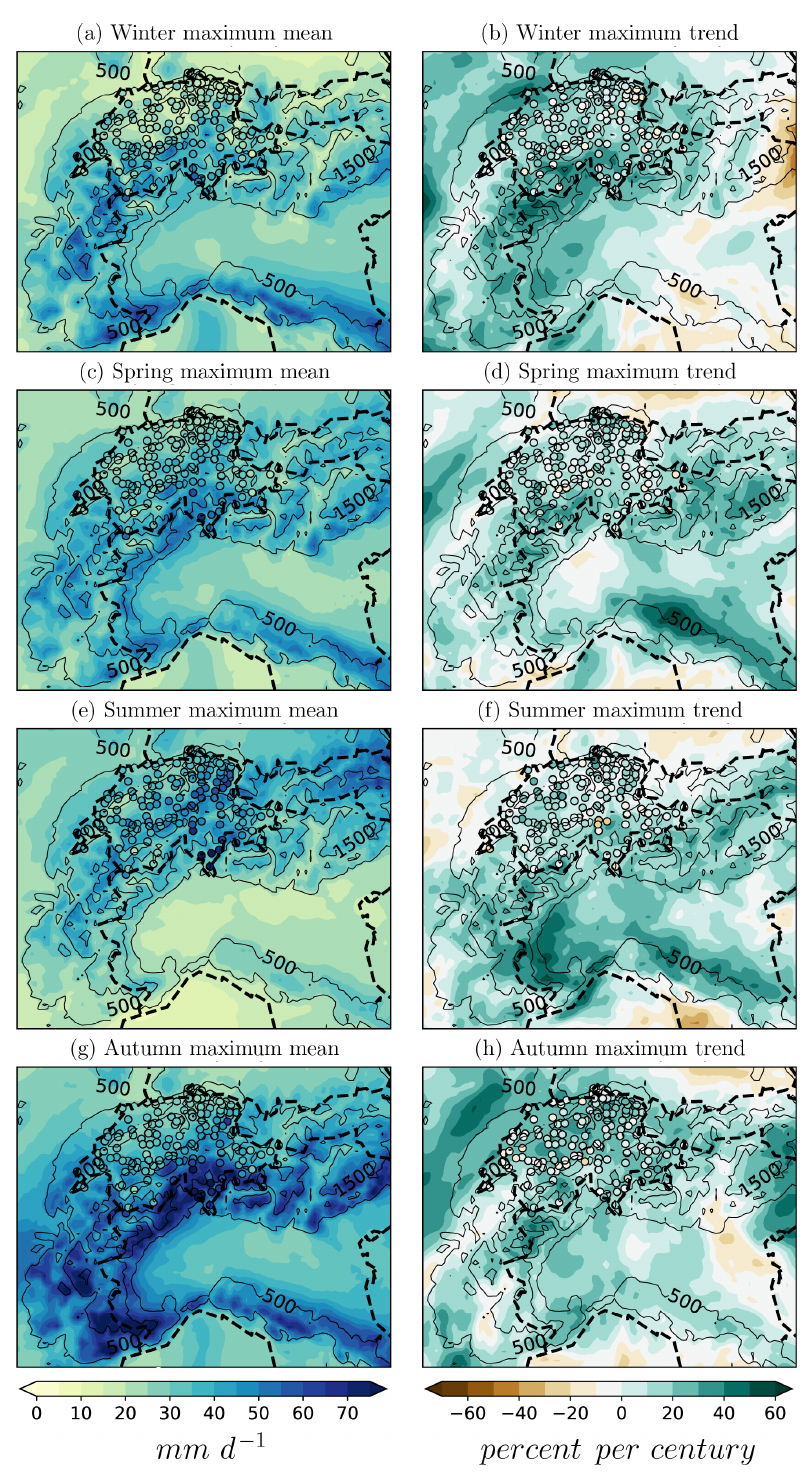
Figure 7. Seasonal mean (mmd − 1 , a, c, e, g ) and trends (% per century, b, d, f, h ) over the period 1903–2010 of the seasonal Rx1day simulated by MAR (shaded) and locally observed in Switzerland (dots) for Winter (a, b) , Spring (c, d) , Summer (e, f) and Autumn (g, h)